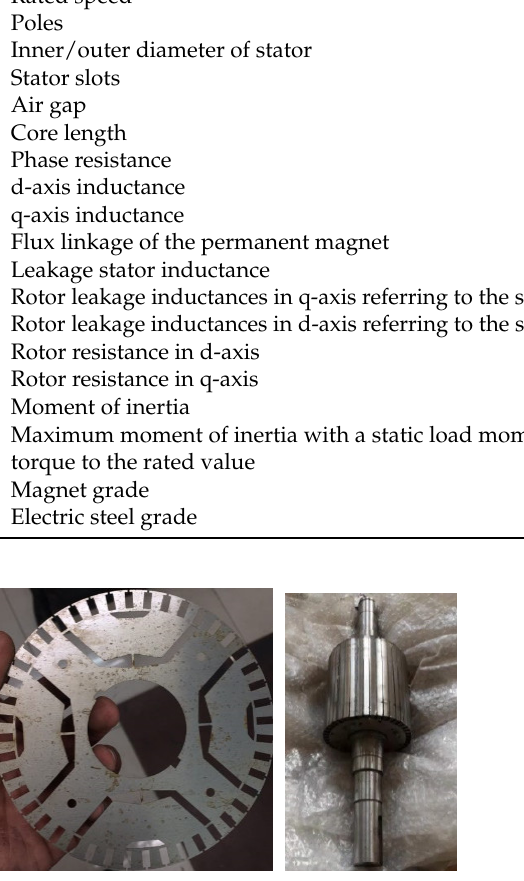
Figure 25. The prototype of the rotor.